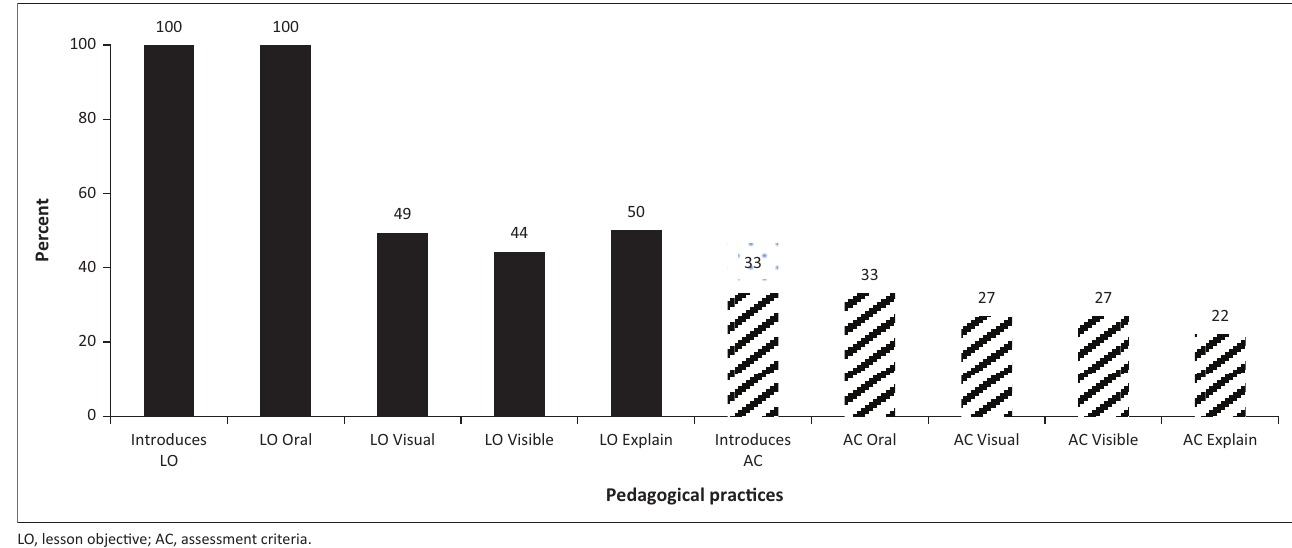
FIGURE 1: Pedagogical practices applied when introducing the lesson objectives and assessment criteria.